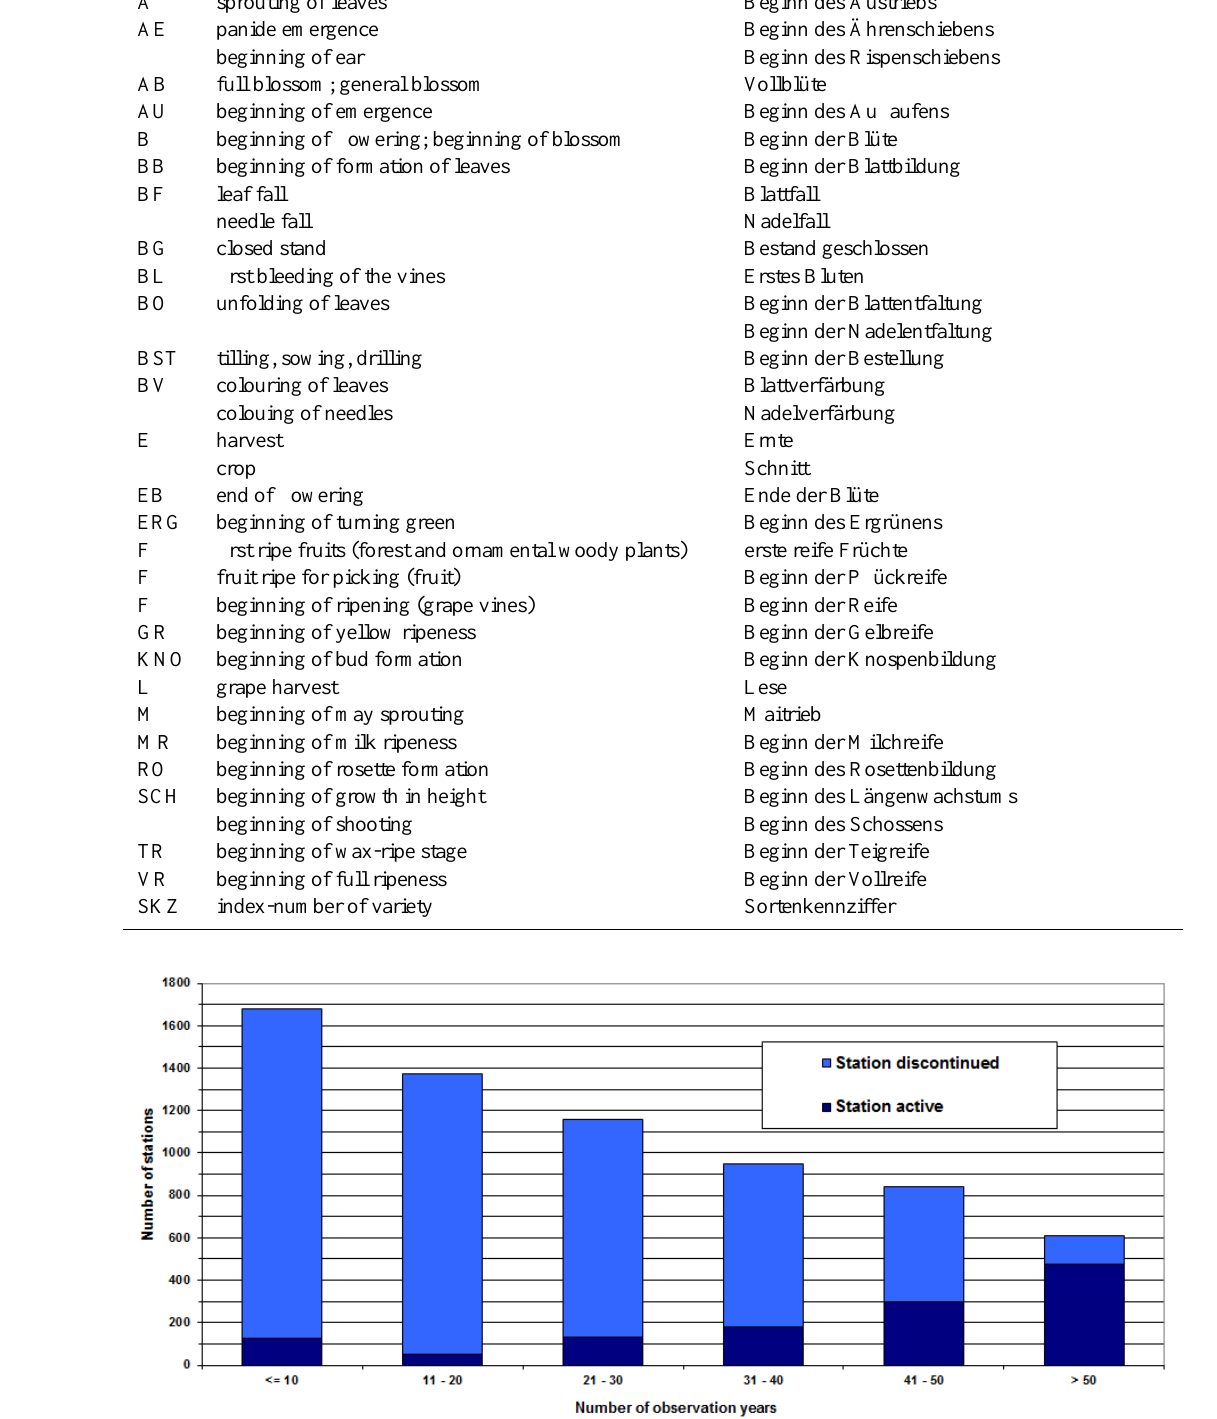
Figure 2. Number of stations in the database and length of their time series (within the period 1951 to